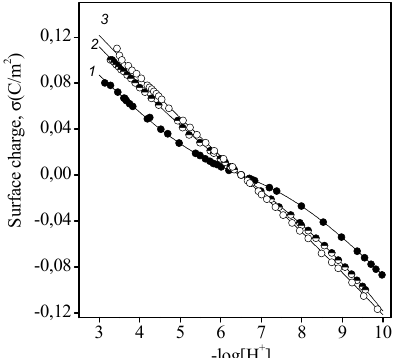
Figure 1. Surface charge as a function of pH and ionic strength: experimentally measured values (symbols) and those calculated in terms of the Basic Stern model (lines) for titanium dioxide. C TiO2 = 10 g/L, C NaCl = 0.001 ( 1 ), 0.05 ( 2 ), and 0.1 ( 3 ) M.